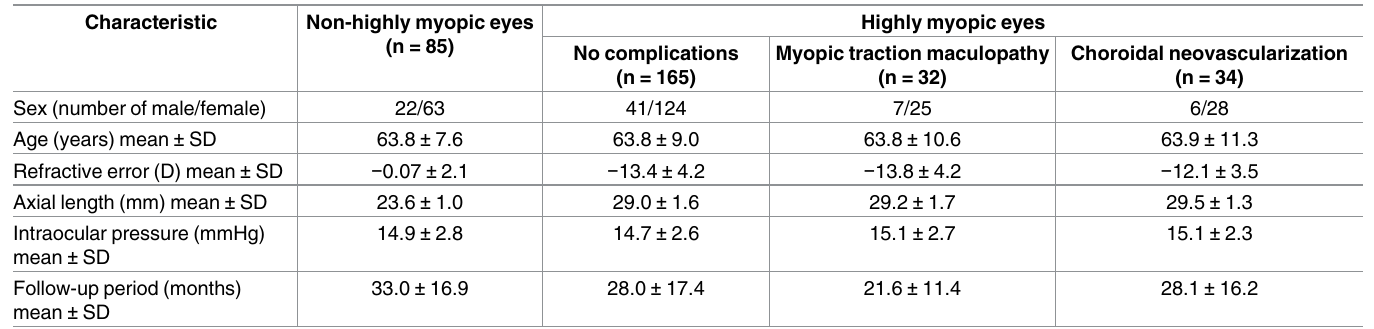
Table 1. Clinical characteristics at the initial examination.